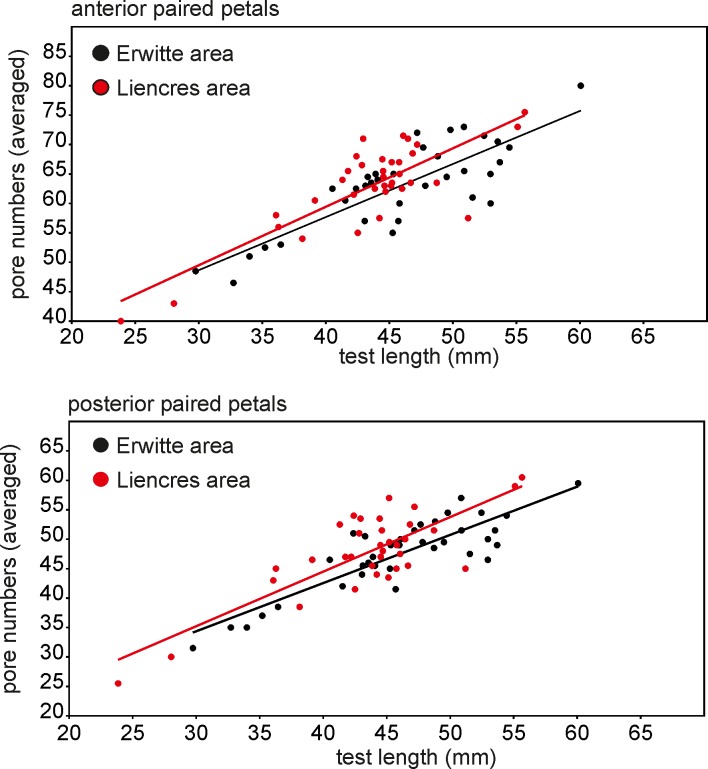
Bivariate scatter plot of the numbers of pore pairs against test length.